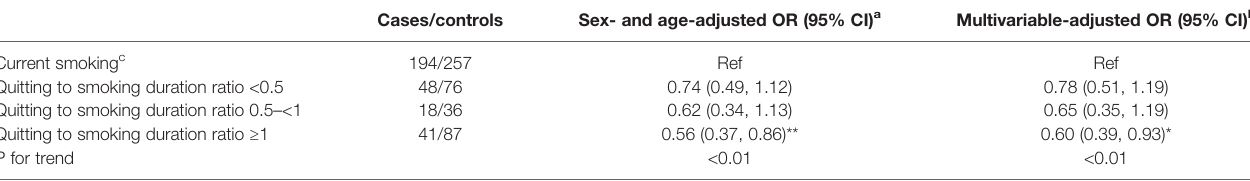
TABLE 4 | Nasopharyngeal carcinoma risk by quitting to smoking duration ratio in subjects aged 18 – 65. Cases/controls